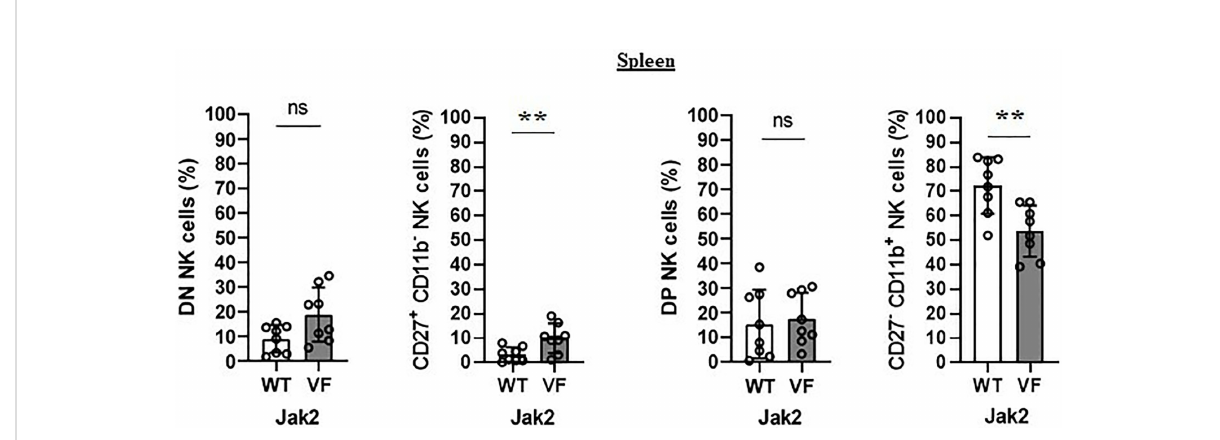
FIGURE 2 The maturation arrest of Jak2V617F murine NK cells is associated with an imbalance between CD27 + and CD11b + NK subsets. The frequency and absolute number of CD27 − CD11b − [double negative (DN)], CD27 + CD11b − , CD27 + CD11b + [double positive (DP)], and CD27 − CD11b + NK cells. VF, Jak2V617F mutated (n = 8); WT, Jak2 wild-type (n = 8). Error bars indicate the mean (± SEM). NS, not signi fi cant (p > 0.05); **p < 0.01; Mann-Whitney